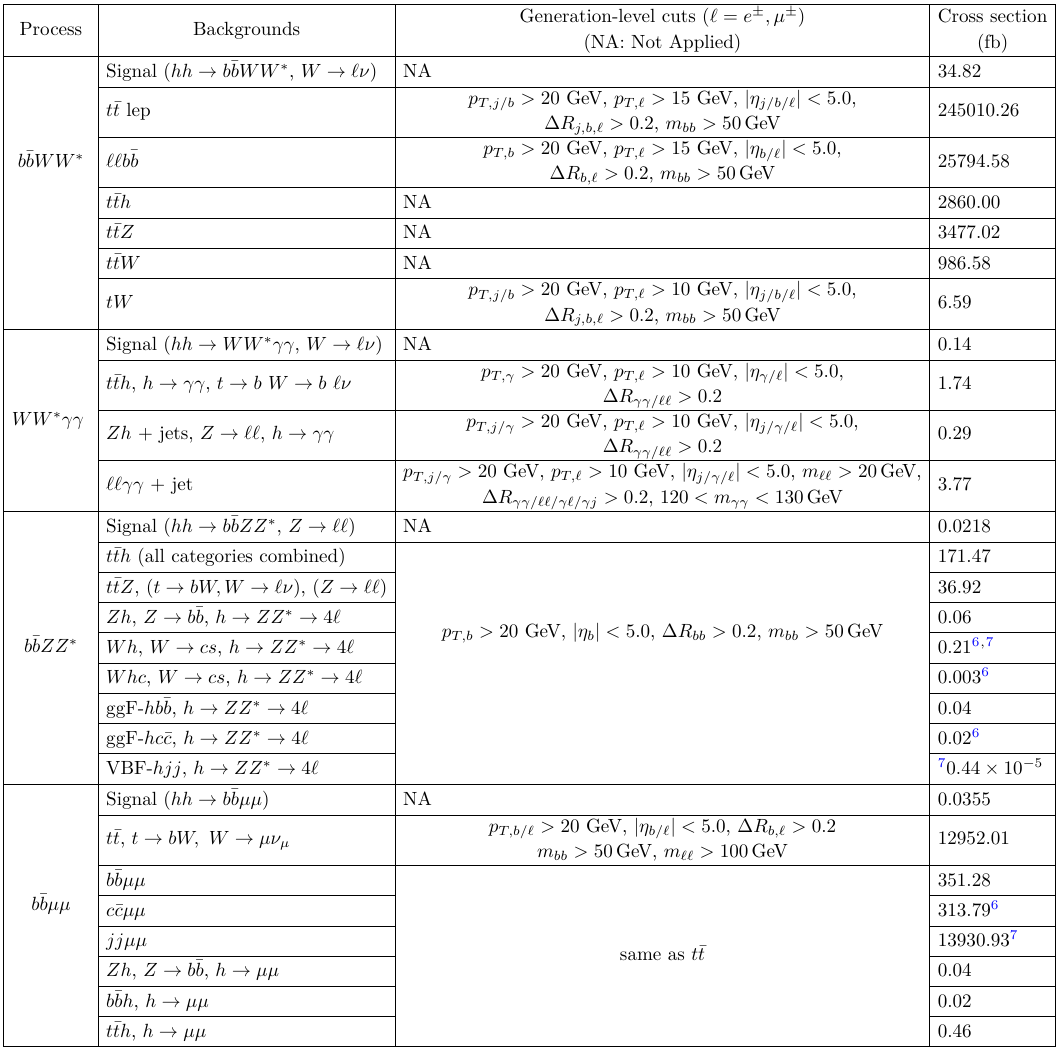
Table 12 . Generation level cuts and cross-sections for the various backgrounds used in the analyses.